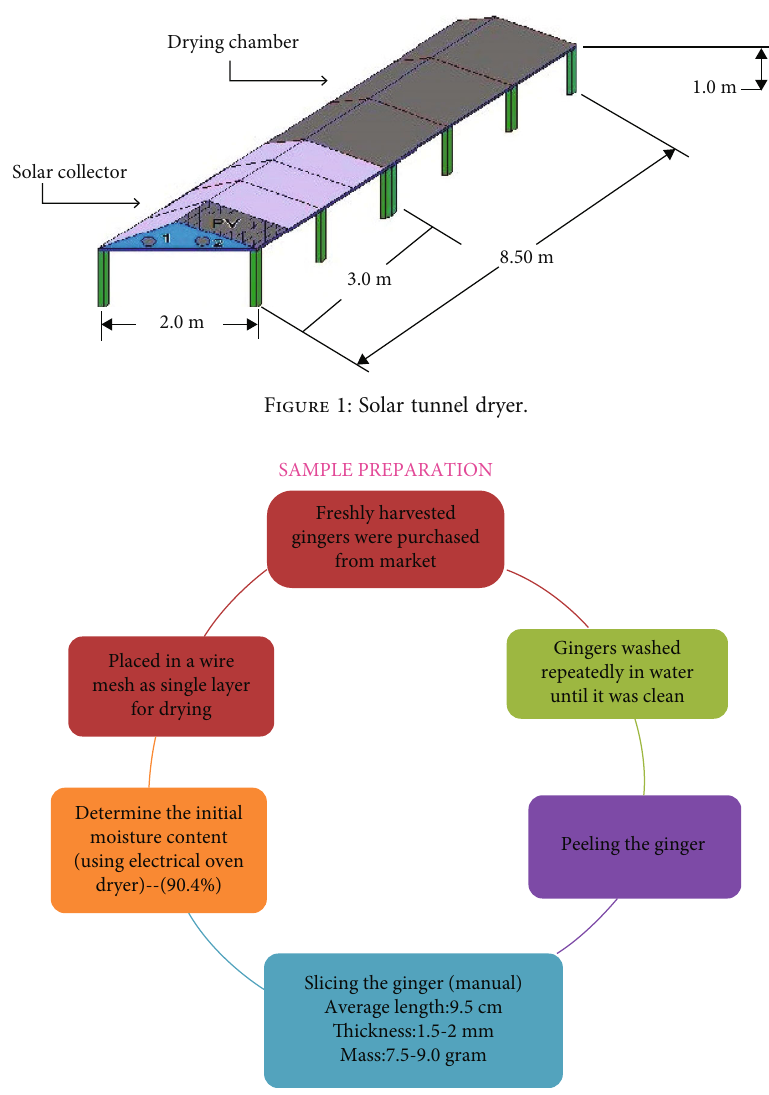
Figure 2: Sample preparation of the